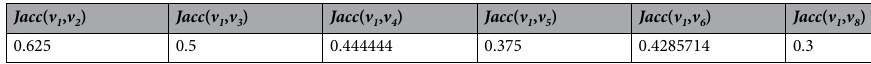
Table 3. The similarity coefficient values of node v 1 and its adjacent nodes.